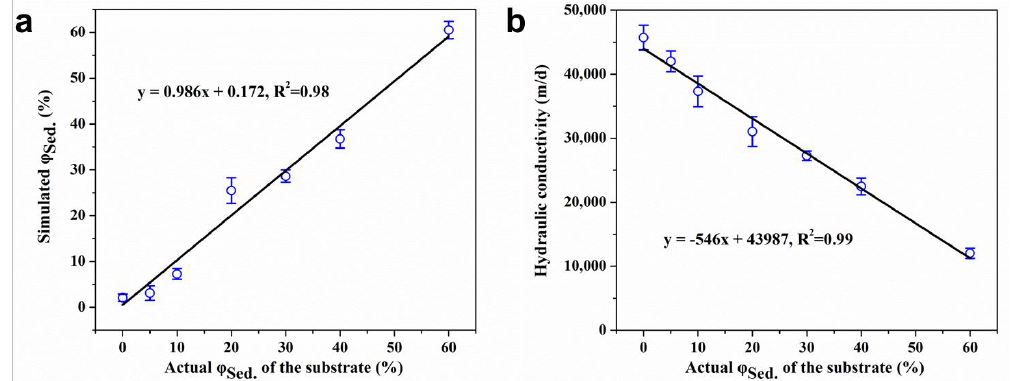
Figure 5. Linear regression of ( a ) simulated sediment fraction ( v / v ) against actual sediment fraction ( v / v ) and ( b ) hydraulic conductivity against actual sediment fraction ( v / v ).